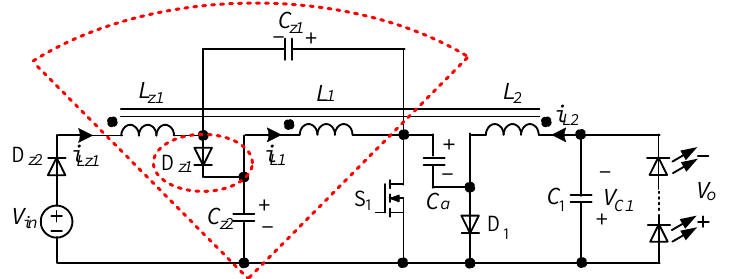
Figure 1. Proposed quasi-Z- source Ćuk LED driver .